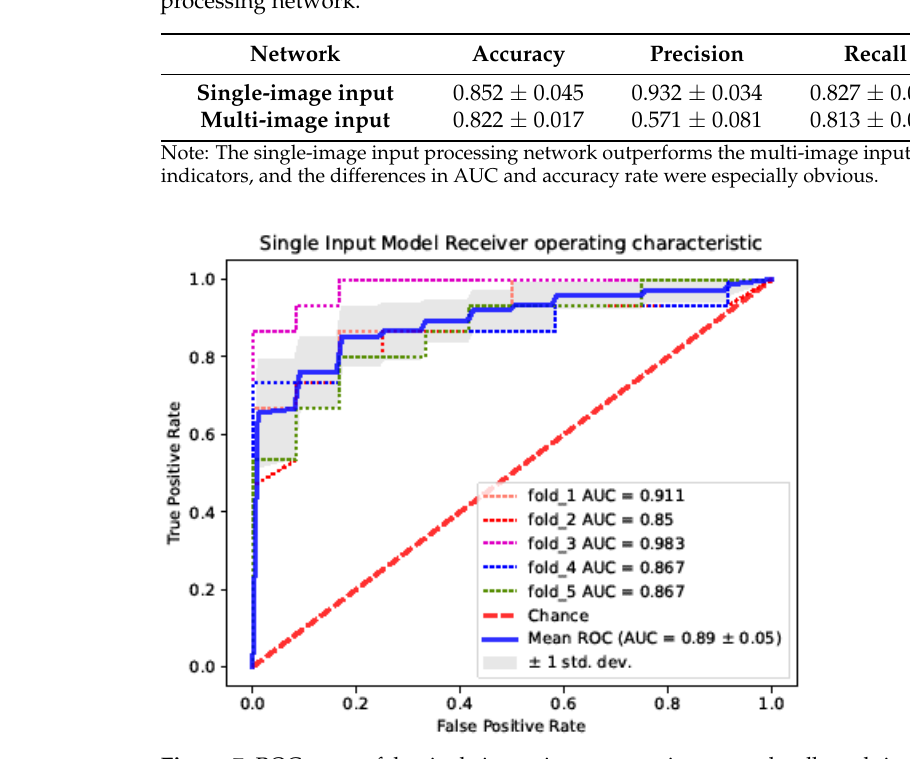
Table 2. Performance of single-image input processing network and multi-image input processing network.